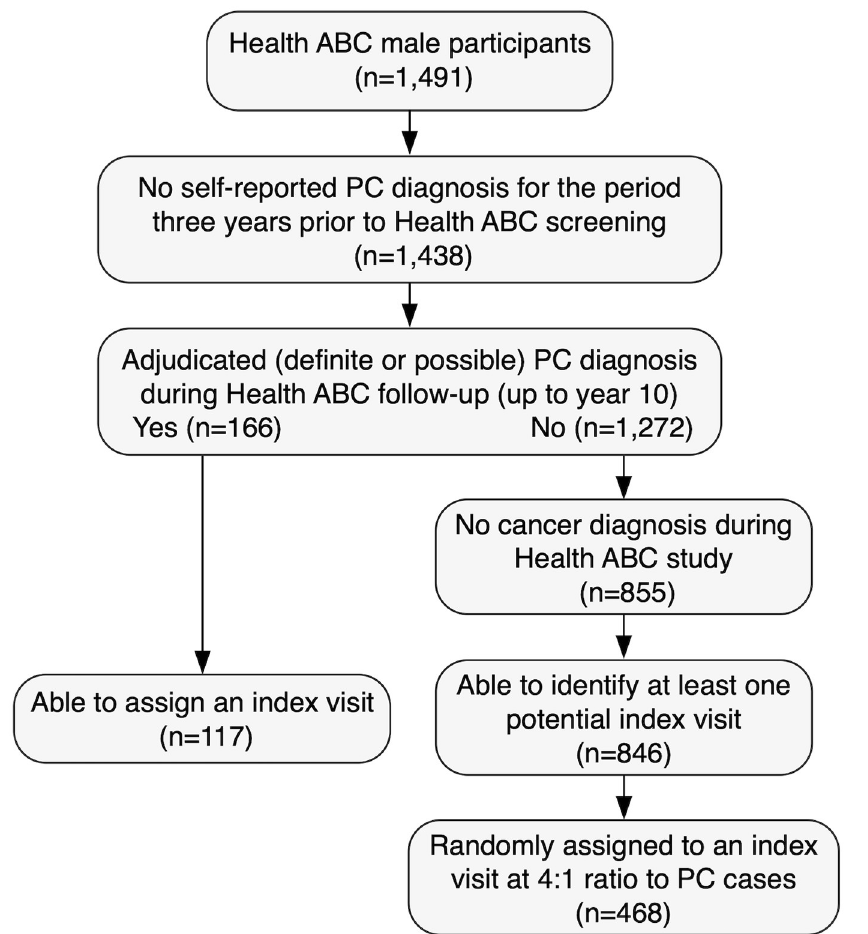
Fig 1. Participant flow chart. CONSORT diagram depicting selection of analytic